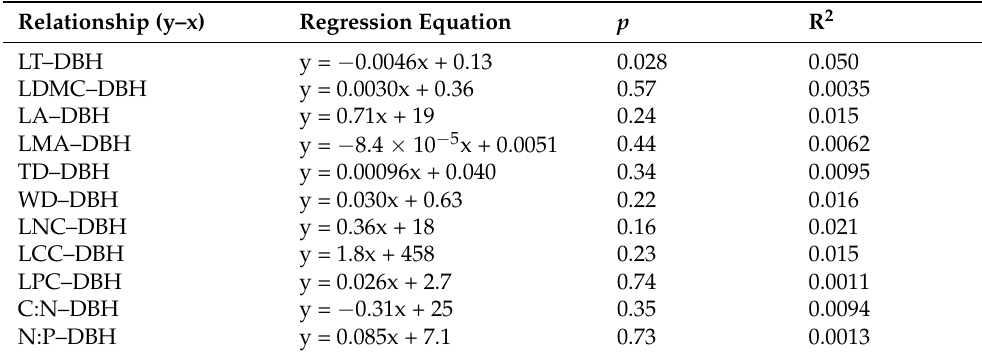
Table 2. Changes in functional traits of L. fragrantissima var. lancifolia with shrub sizes.